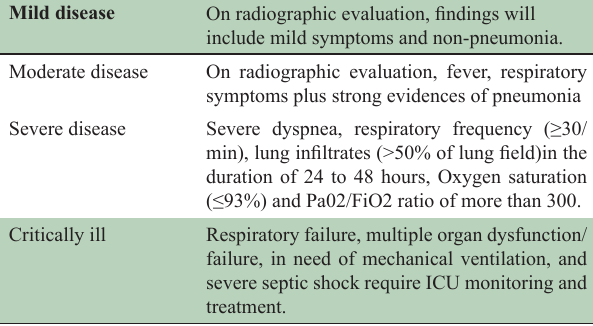
Table-I: Severity of COVID-19 Criteria.